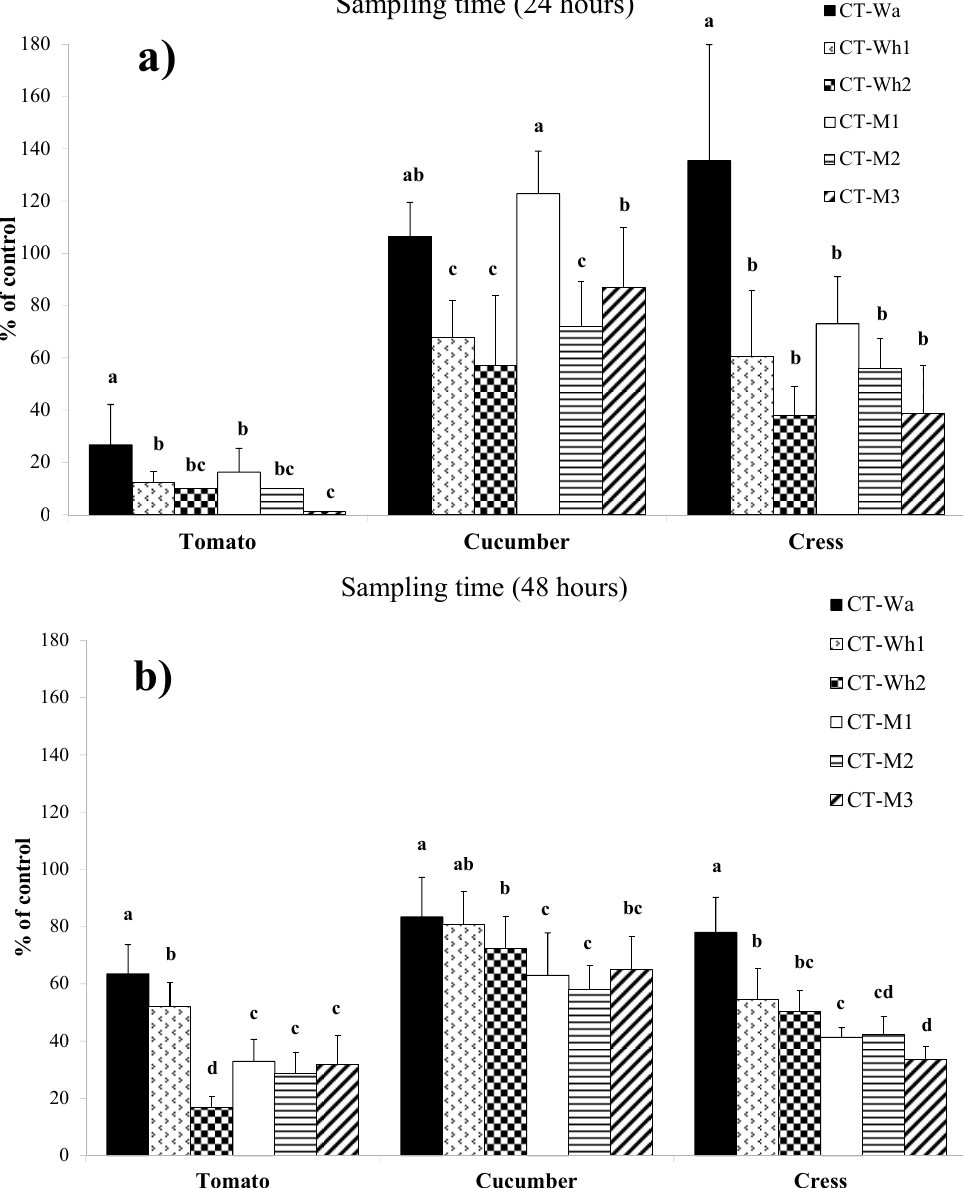
Figure 4. Phytotoxicity assays on seeds of Solanum lycopersicum L. (tomato), Cucumis sativus L. (cucumber) and Lepidium sativum L. (cress) treated with the different CTs (1:3 v : v , CT: water) sampled after 24 ( a ) and 48 h ( b ) from the start of the extraction process. Lowercase letters indicate statistically significant differences ( p ≤ 0.05) within the same sampling time.